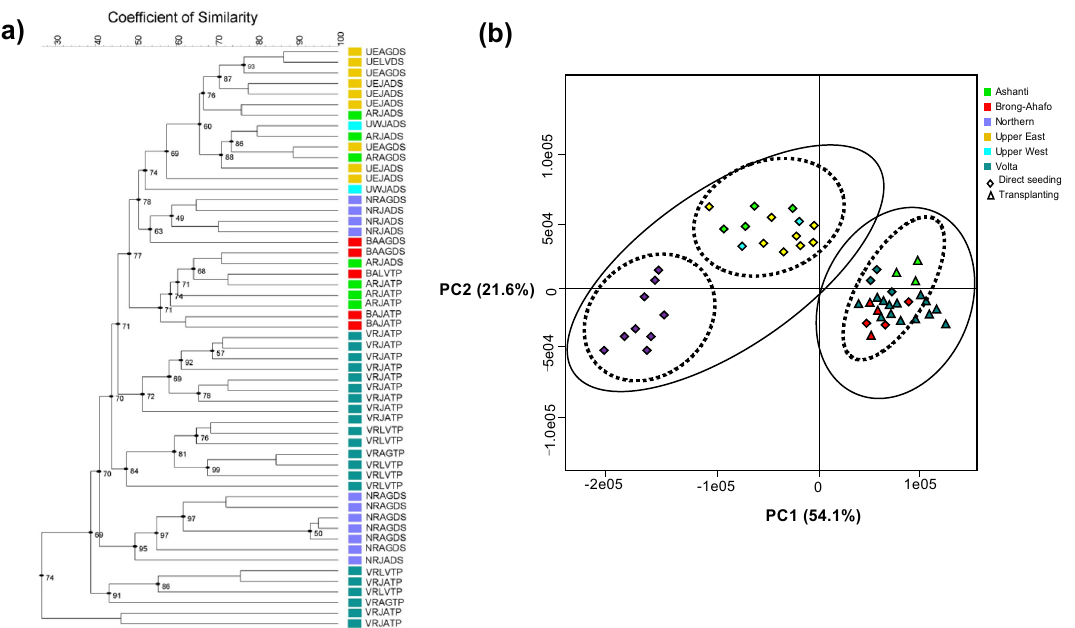
Figure 3. Comparison of results from clustering and ordination analysis of denaturing gradient gel electrophoresis (DGGE) profiles showing arbuscular mycorrhizal fungi (AMF) communities in colonized rice roots from six different regions in Ghana. ( a ) The dendrogram from the cluster analysis used a similarity matrix (Dice coefficient) based on region, rice cultivar, and farming system. The colors show the 6 sampled regions, namely, Ashanti (AR), Brong-Ahafo (BA), Northern (NR), Upper East (UE), Upper West (UW), and Volta (VR). Rice cultivar: Jasmine85 (JA), AgraRice (AG), and Local variety (LV); farming system: direct seeding (DS) and transplanting (TP). ( b ) Principal component analysis (PCA) with similarities explained by the first two components as 21.6%–54.1% of the variability. The diamond and triangle shapes represent the farming systems under which rice is cultivated.